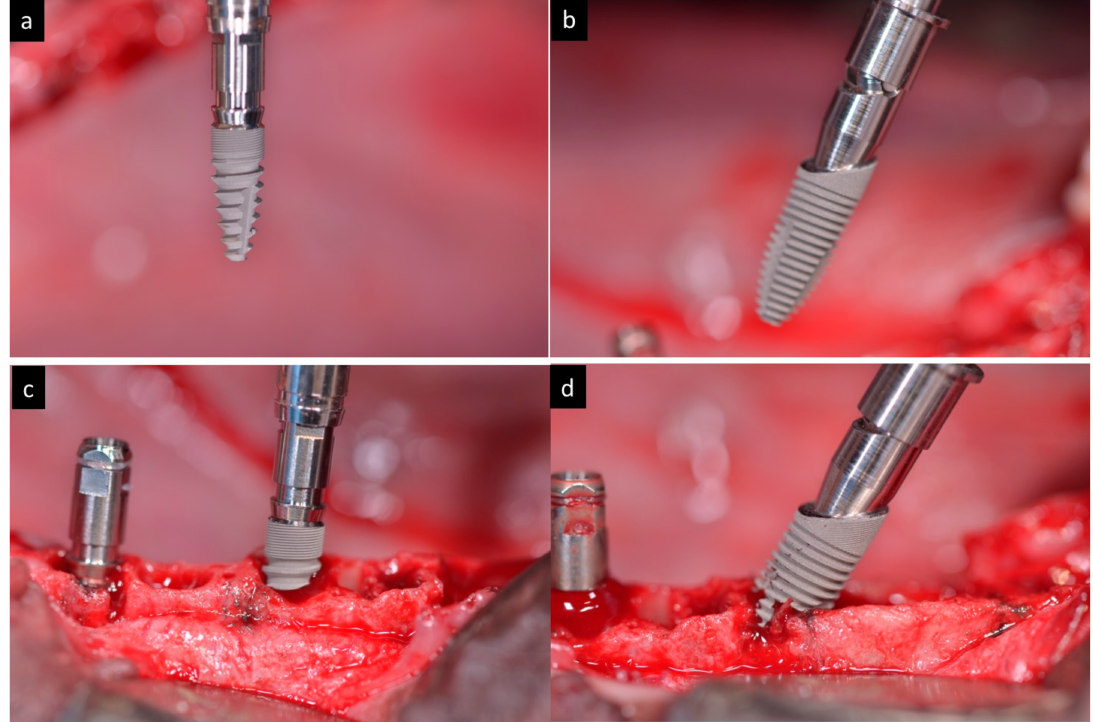
Figure 3. ( a ) Macroscopically aspect of the axial implant. ( b ) Macroscopically aspect of the sloped implant. ( c ) Insertion of an axial implant. ( d ) Insertion of a sloped implant. The implants were submerged with their platforms located 1 mm sub crestal (Figure